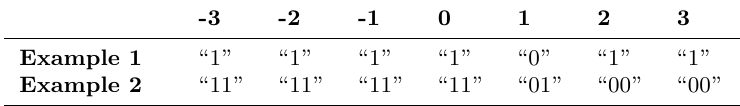
Table 2: Designed codewords to distinguish coefficient 1 from other coefficients -3 -2 -1 0 1 2 3 Example 1